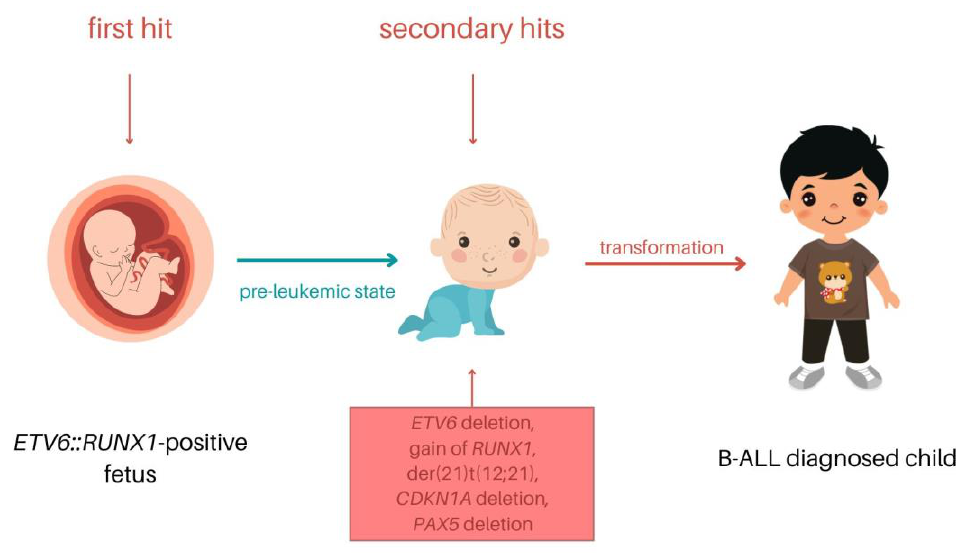
Figure 4. The model of the pediatric ETV6::RUNX1 B-ALL process.